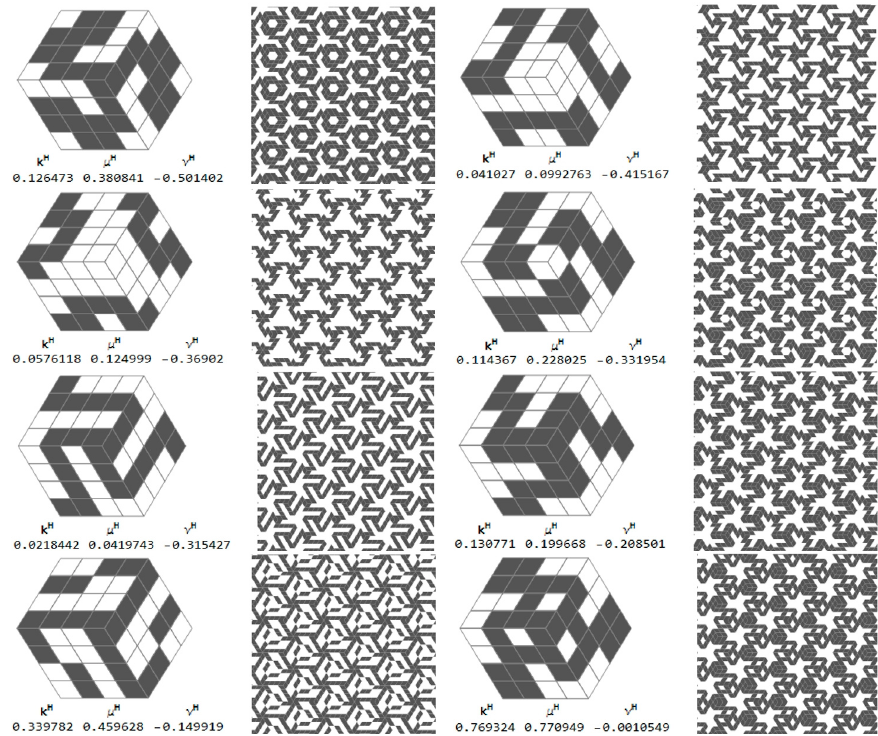
Figure 13 Selected auxetic 1st rank isotropic microstructures and the effective moduli. Cells of periodicity, and the tessellated patterns.